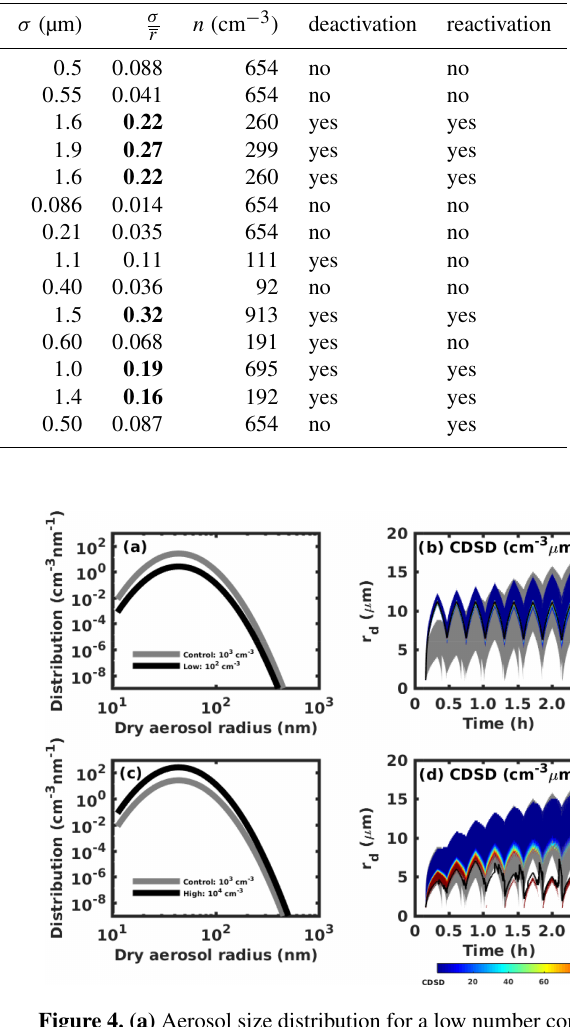
Figure 4. (a) Aerosol size distribution for a low number concentra- tion of 10 2 cm − 3 . (b) Cloud droplet size distribution changes with time for the low aerosol number concentration case. (c) Aerosol size distribution for the high number concentration of 10 4 cm − 3 . (d) Cloud droplet size distribution changes with time for the high aerosol number concentration case. Gray lines in (a) and (c) repre- sent the control case with a total aerosol number concentration of 10 3 cm 3 , and gray regions in (b) and (d) are the range of the cloud droplet size spectrum for the control